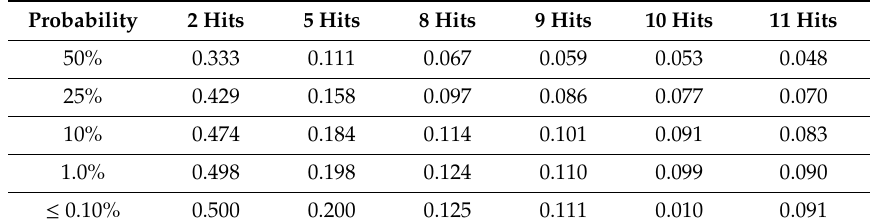
Table 3. Quotient between expected spike height and probability obtained for different combinations of probability and number of hits.